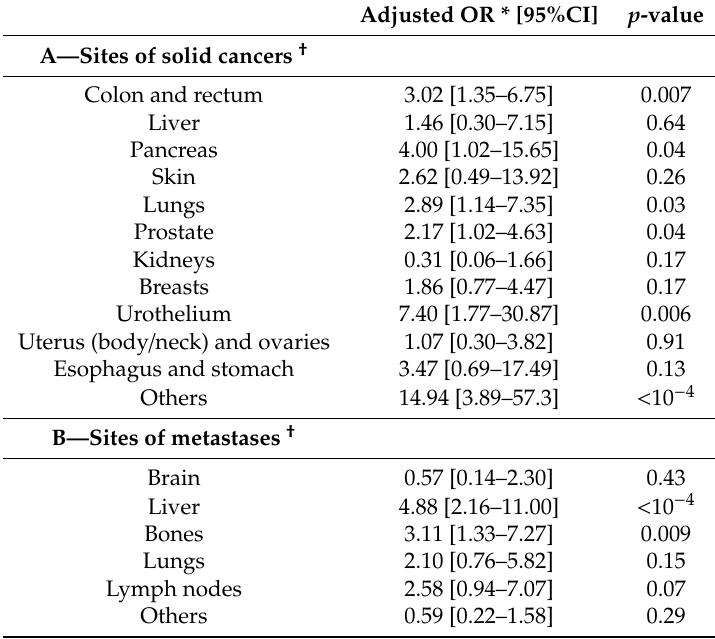
Table 4. Association between plasma vitamin B12 ≥ 1000 ng / L and solid cancers according to cancer and metastatic sites in multivariate